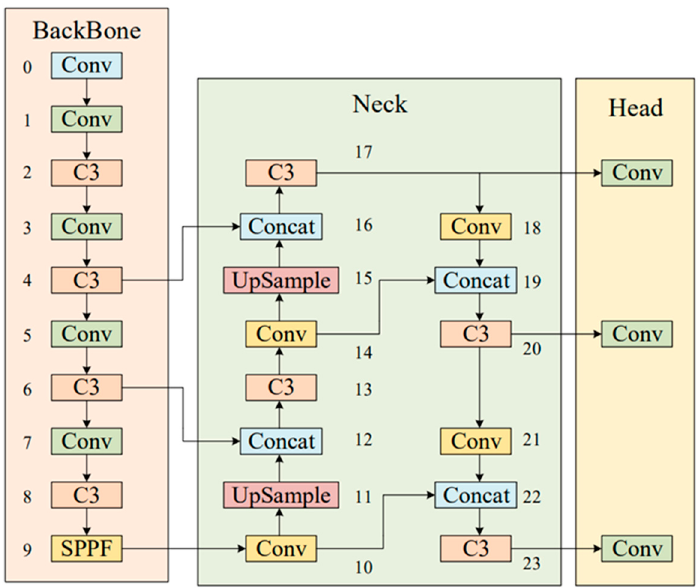
Figure 1. Structure diagram of YOLOv5.